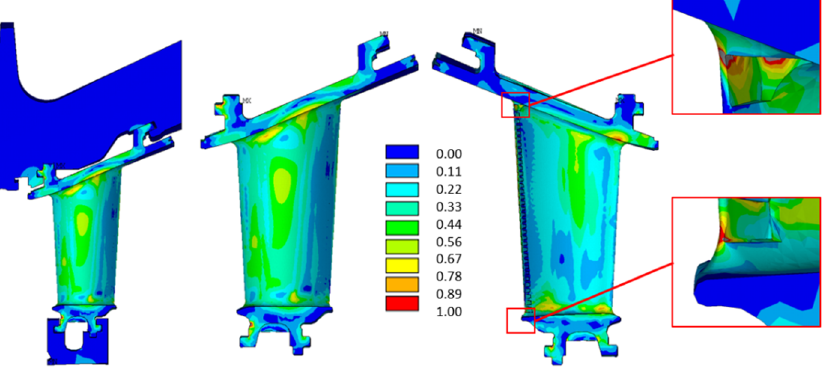
Figure 15. Equivalent von Mises stress. The yield strength of the material is exceeded in the two areas marked in the images, the platform exterior trailing edge (PETE) and the platform interior trailing edge (PITE). Stresses are normalized with respect to the maximum von Mises stress value.